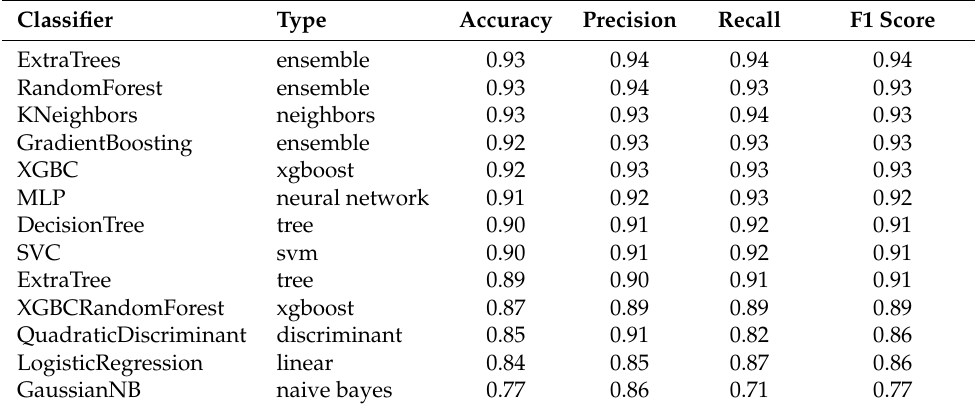
Table 6. Different metrics obtained by the classifiers for the entire time-series in the evaluation phase.